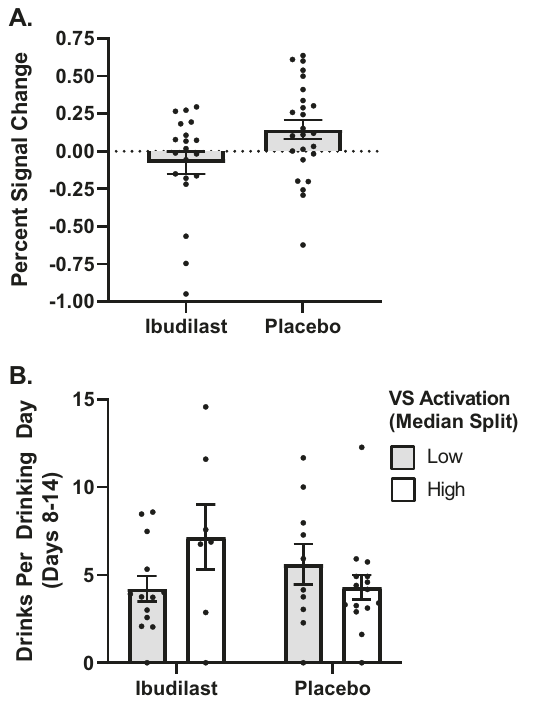
Fig. 3 Effect of ibudilast on alcohol cue-induced activation in the ventral striatum. A IBUD attenuated the percent signal change to alcohol vs. beverage cues as compared to placebo ( p = 0.01). B Medication by ventral striatal activation interaction. There was a signi fi cant medication by striatal activation (median split) interac- tion ( p = 0.01). Individuals treated with IBUD who showed attenu- ated ventral striatal activation to alcohol cues had the fewest drinks per drinking day in the week following the fMRI